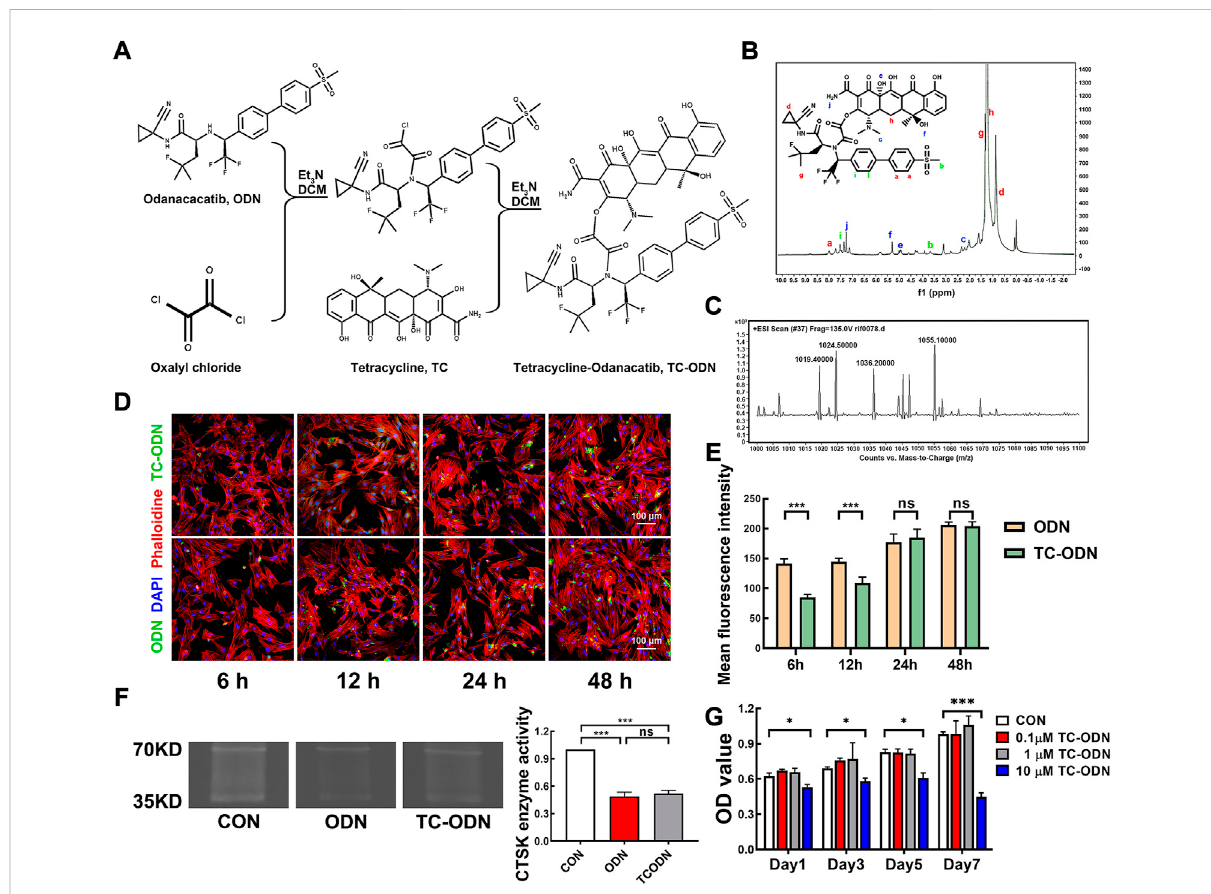
FIGURE 1 Fabricationandcharacterizationofmultifunctionaldrug(TC-ODN). (A) Indirectconjugationoftheaminogroupofodanacatibwiththehydroxyl group of TC via oxalyl chloride. (B) 1 H-NMR spectroscopy of TC-ODN. (C) Mass spectrometry of TC-ODN. (D) Representative images of cellular uptake of odanacatib and TC-ODN. (E) The fl uorescence intensity of odanacatib and TC-ODN at each time point is presented ( n = 3). (F) Representative images of gelatin spectrum test for CTSK enzyme activity and the semi quantitative analysis ( n = 3). (G) Cytotoxicity of TC-ODN in vitro ( n = 3). Data are presented as means ± SD. * p < 0.05 and *** p < 0.001 by one-way